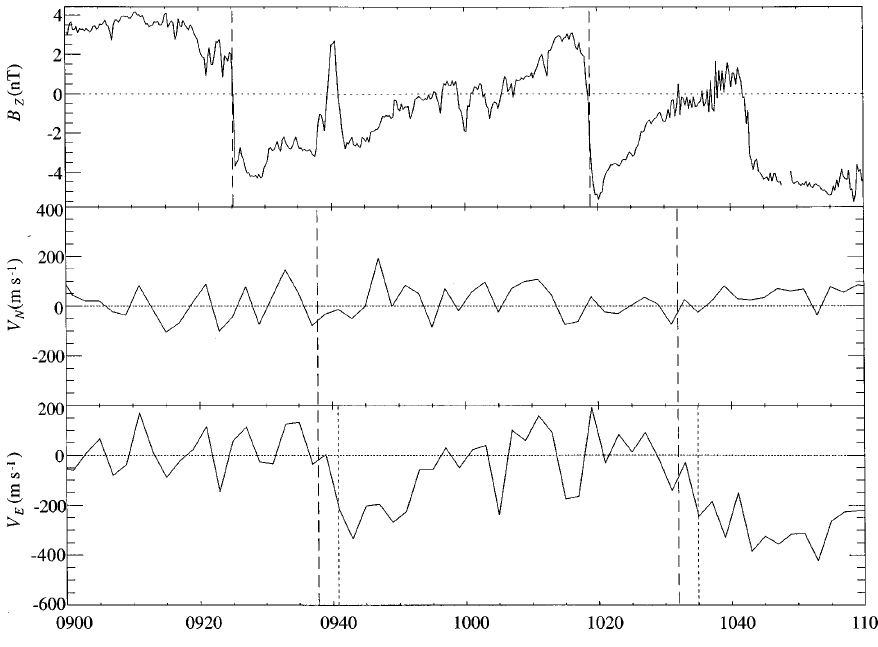
Fig. 2. Simultaneous IMP-8 magnet- ic field data and EISCAT CP-1-K velocity data for the interval 0900– 1100 UT (1130–1330 MLT) on 14 February, 1996. The top panel shows 15 s values of the IMF B field z component, while the lower two pan- els show 2 min values of the magnetic north and magnetic east components of the field-perpendicular velocity measured by the radar. Two south- ward turnings of the IMF are marked by the dashed vertical lines in the upper panel , whose e(cid:128)ects are expect- ed to arrive in the ionosphere at the times indicated by the dashed vertical lines in the lower panels . The times at which the first clear e(cid:128)ects were observed in the flow components are shown by the dotted vertical lines in the lower